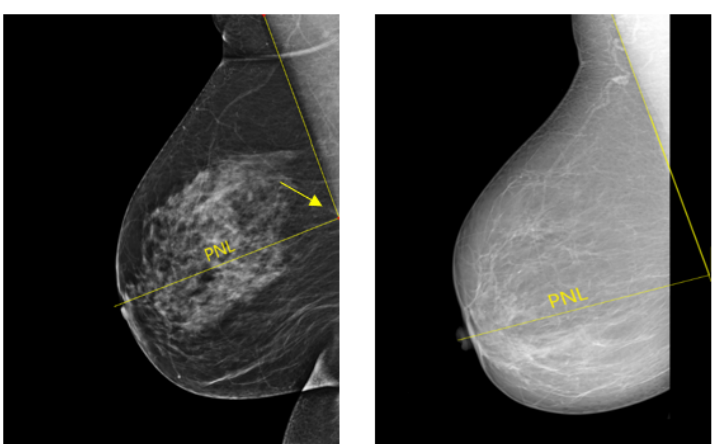
Figure 20. Example of adequately and inadequately positioned MLO views. ( Left ): a well-positioned MLO view in which the pectoralis muscle line and the posterior nipple line (PNL) intersect within the image area (cf. yellow arrow). ( Right ): an inadequately positioned MLO view where the pectoralis muscle line and the PNL do not cross within the image